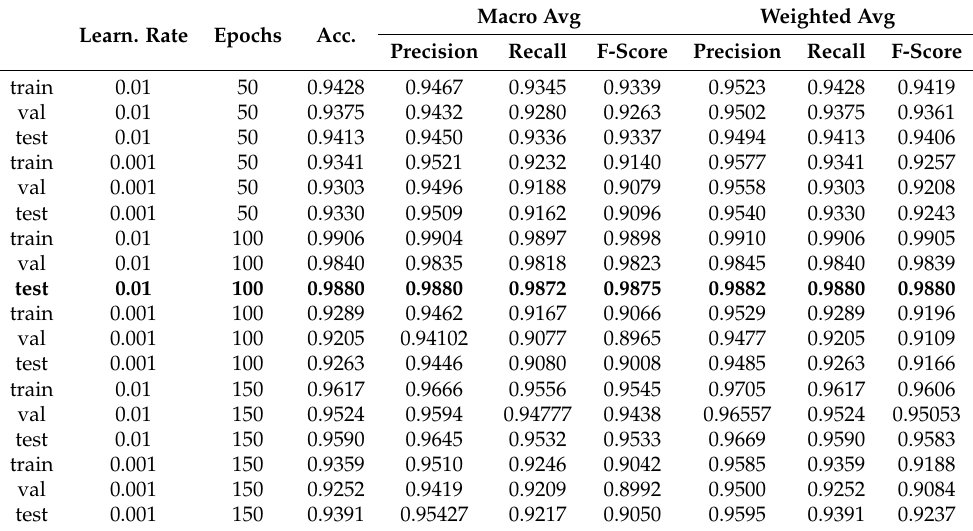
Table 3. Results of first Neural Network model for Adaptive Moment Optimization (Adam) optimizer using signal strength data from LoRa.